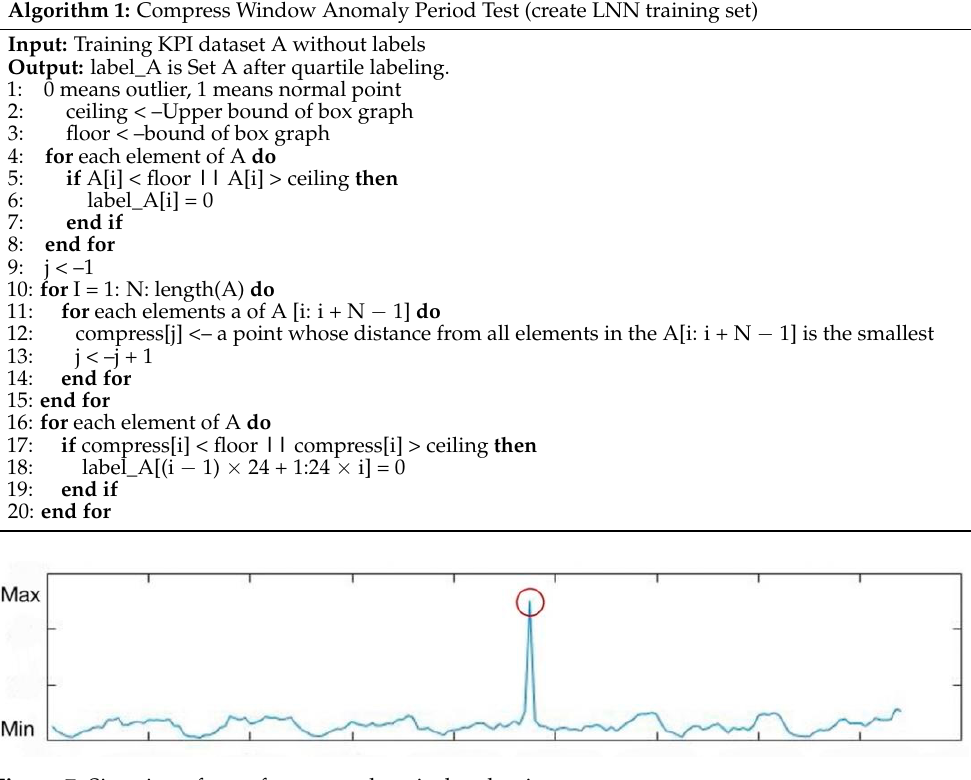
Figure 7. Situation of very few anomalous isolated points.